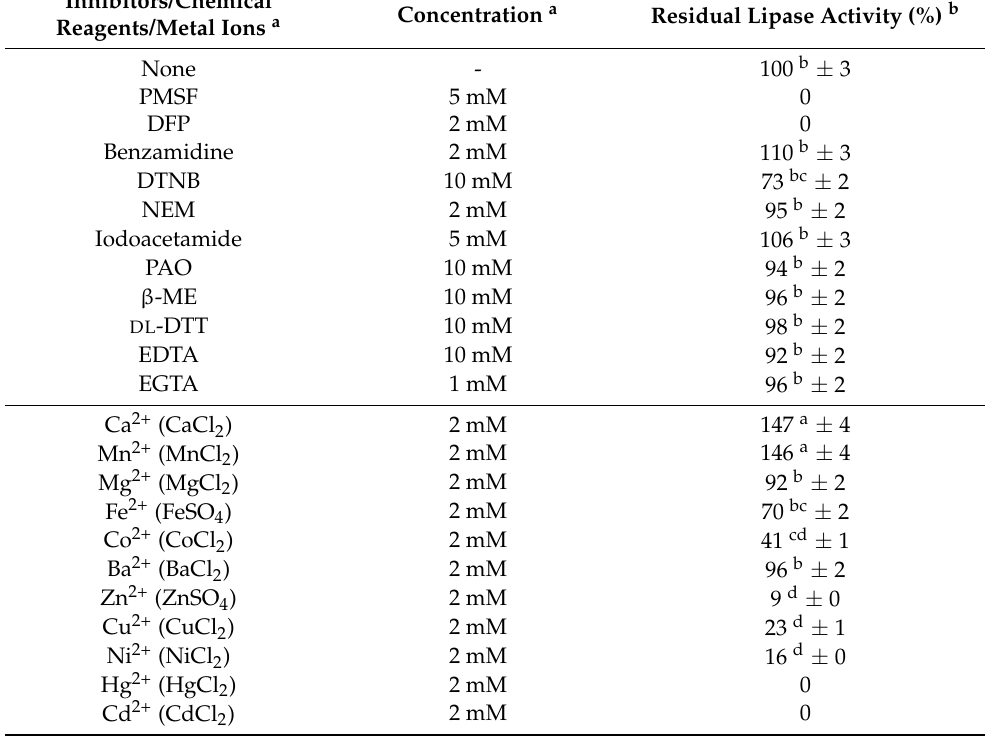
Table 3. Effects of various inhibitors, chemical reagents, and metallic ions on the purified lipase PCrL. The enzyme assay was performed after the pre-incubation of the enzyme with each inhibitor or reducing agent, or each metallic ion-tested compound, for 1 h at 37 ◦ C. The lipase activity measured in the absence of any inhibitor or reducing agent was taken as the control (100%). The non-treated and dialyzed enzyme was considered as 100% for the metal ion assay. Residual activity was measured at pH 9 and 37 ◦ C. Inhibitors/Chemical Concentration a Residual Lipase Activity (%) b Reagents/Metal Ions a None - 100 b ± 3